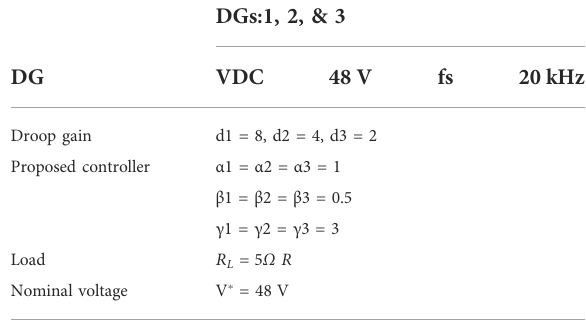
TABLE 1 Parameters on controllers and the MG system.